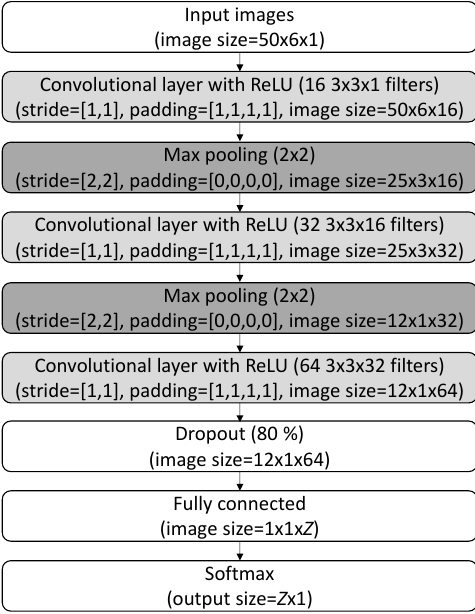
Figure 7. The architecture of the convolutional neural network used to discriminate AE sources. The parameter Z here indicates the number of zones.